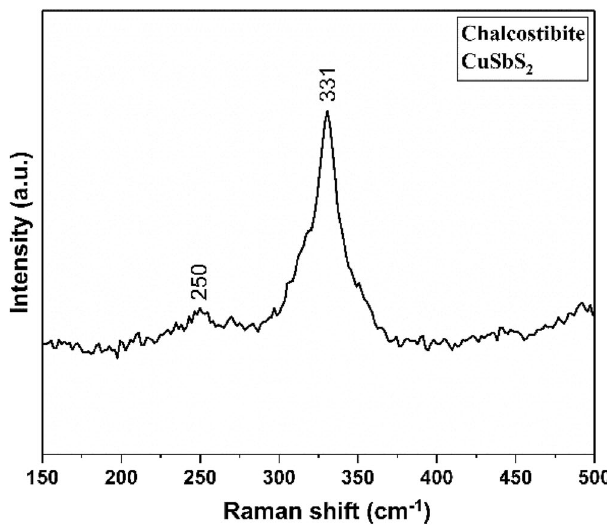
Figure 3. Raman spectrum of chalcostibite CuSbS 2 prepared using a 1: 1 ratio of Cu and Sb xanthate powders at 250 °C.